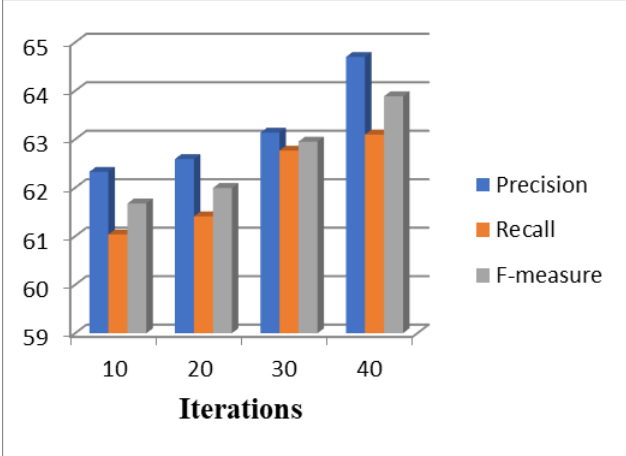
Figure 6. Precision, Recall and F-Measure values for the existing Cuckoo